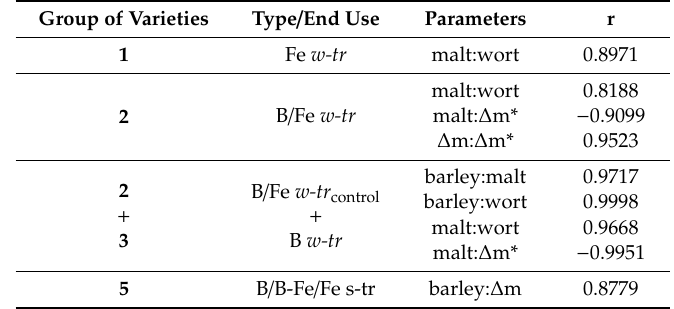
Table 4. Statistically significant correlation between the β -glucan share in barley, malt, and wort and its degradation degree during malting ( ∆ m and ∆ m*) for di ff erent purpose varieties (Pearson correlation matrix).